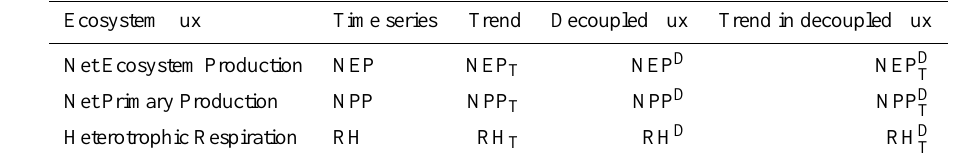
Table 2. Acronyms used to identify the different ecosystem flux components and temporal signals. Ecosystem